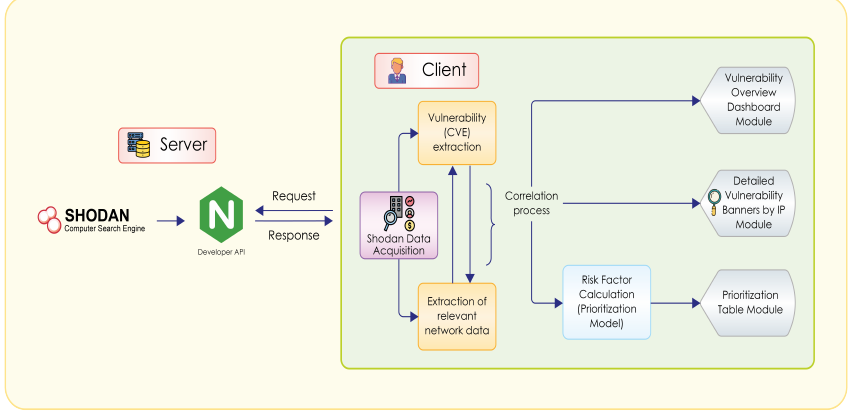
Figure 6. Architecture of the prototype’s resource consumption and data processing